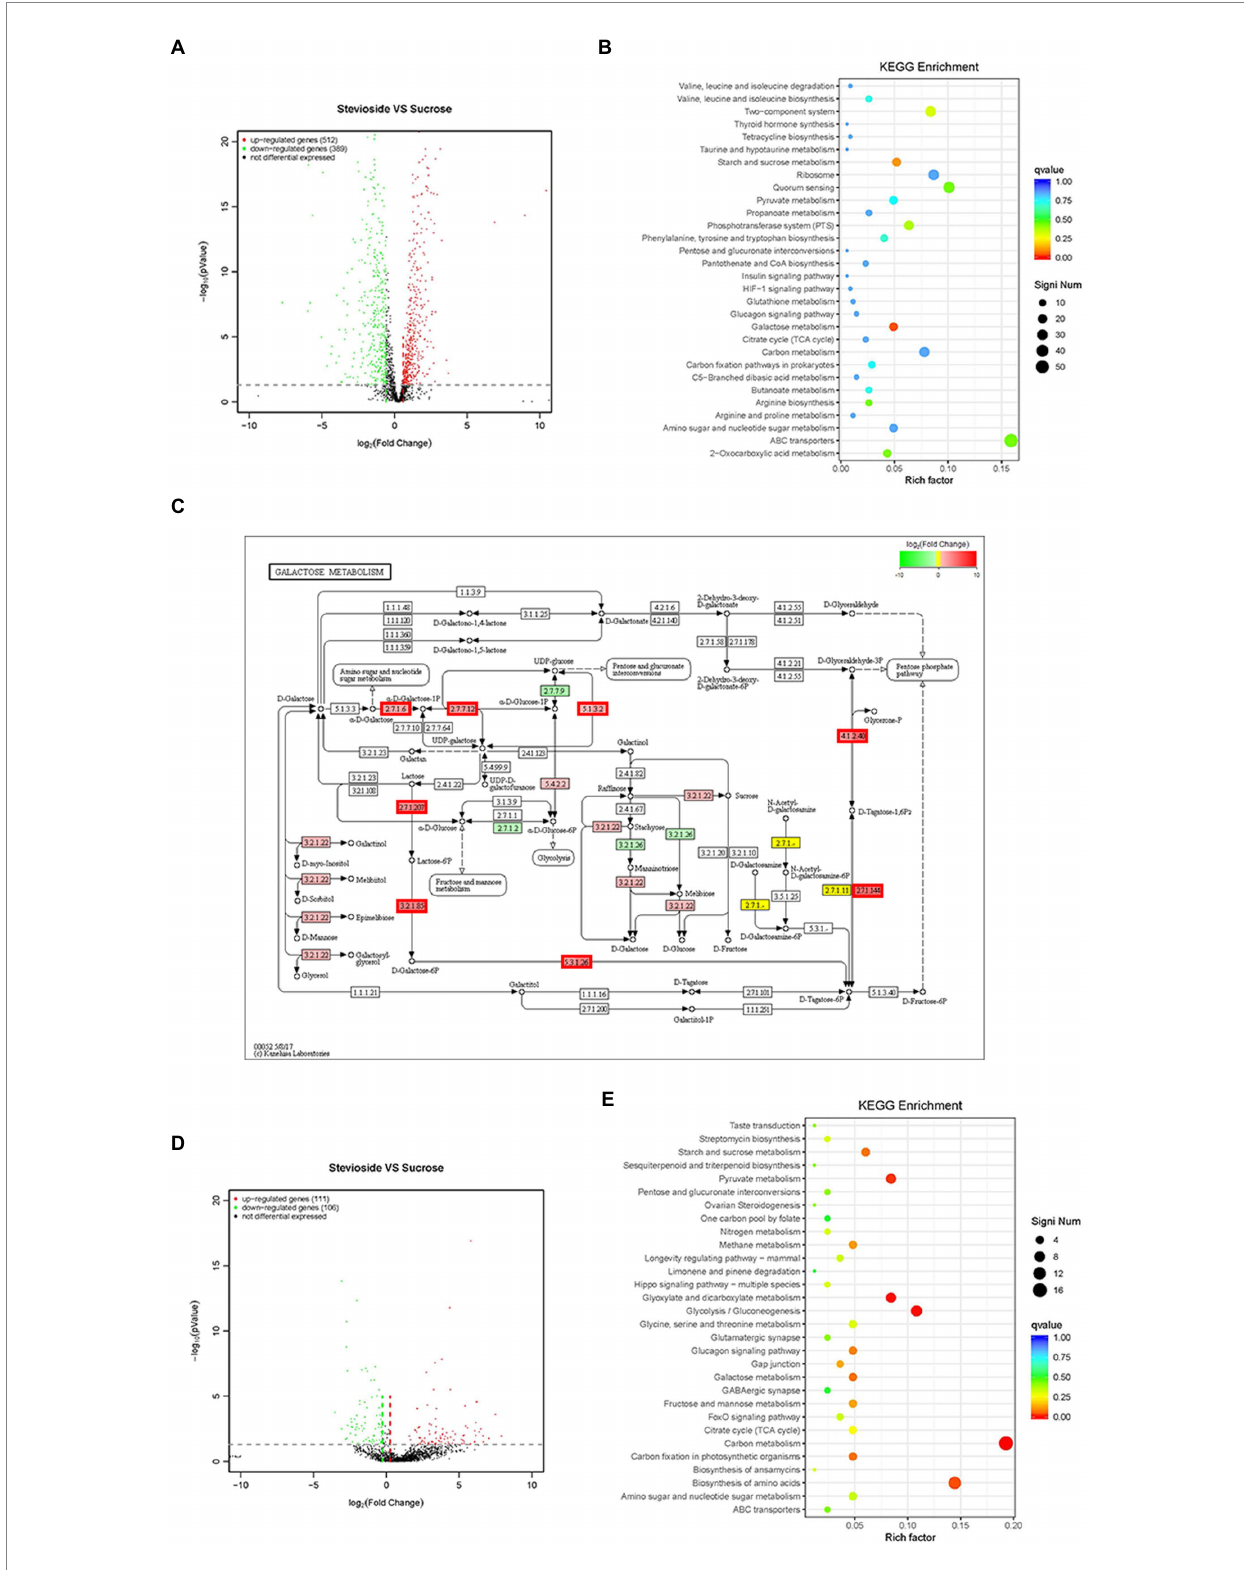
FIGURE 7 Effects of stevioside through RNA-Seq analysis in S. mutans and C. albicans dual-species biofilms. (A) , (D) Volcano plot illustrating genes with significant expression differences of S. mutans and C. albicans in mixed-species biofilms in the stevioside group (versus sucrose group). (B) , (E) KEGG pathways analysis in the stevioside group compared with in sucrose groups. (KEGG, Kyoto Encyclopedia of Genes and Genomes) (QValue, a Benjamini– Hochberg adjusted p value). (C) KEGG galactose metabolism map (ko00052) of S. mutans in the stevioside group (versus sucrose group) in